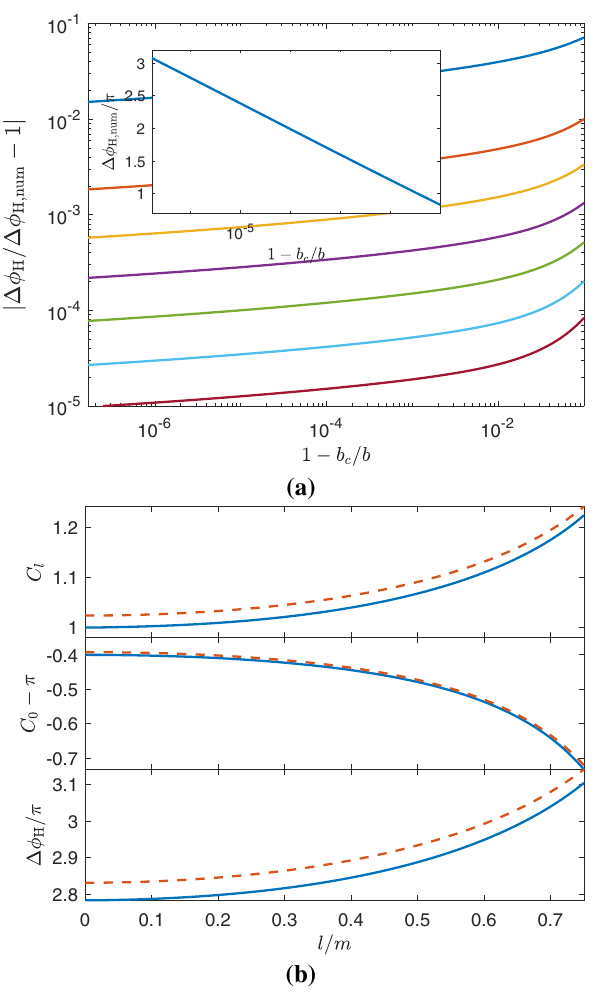
Fig. 3 a | (cid:8)φ H /(cid:8)φ H,num − 1 | for l / m = 1 / 2 and v = 1 and Eq. (56) truncated at order 0, 2, 4, 6, 8, 10 and 12 (from top to bottom). Inset: numerical value obtained from Eq. (5). b Variation of coefficients